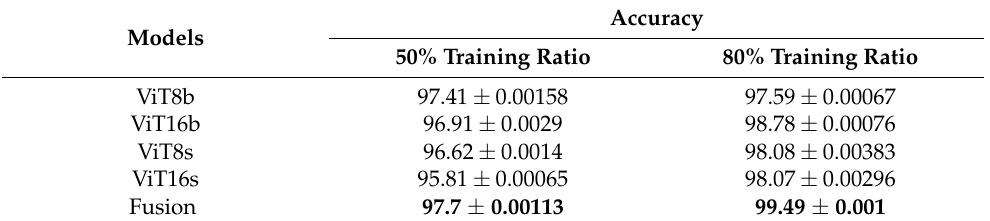
Figure 6. Rate of important feature effects on the classification accuracy of the UC Merced data set with 80% of randomly selected images per class. Table 2. Comparison with different ViT features on the UC Merced data set.